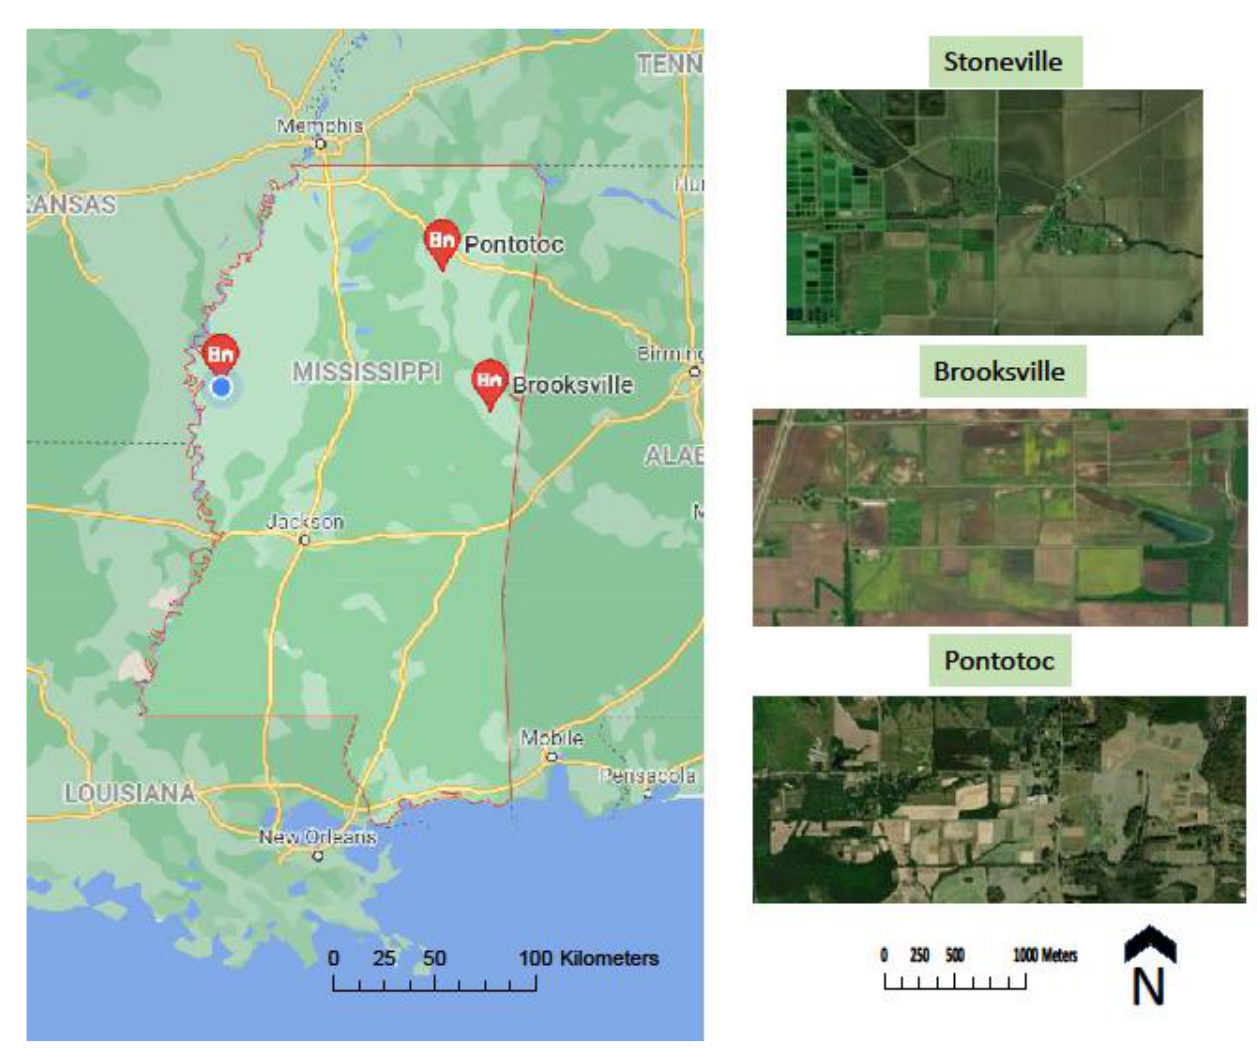
Figure 1. Google/Google Earth maps of the demonstration sites at three locations in lower northern Mississippi.